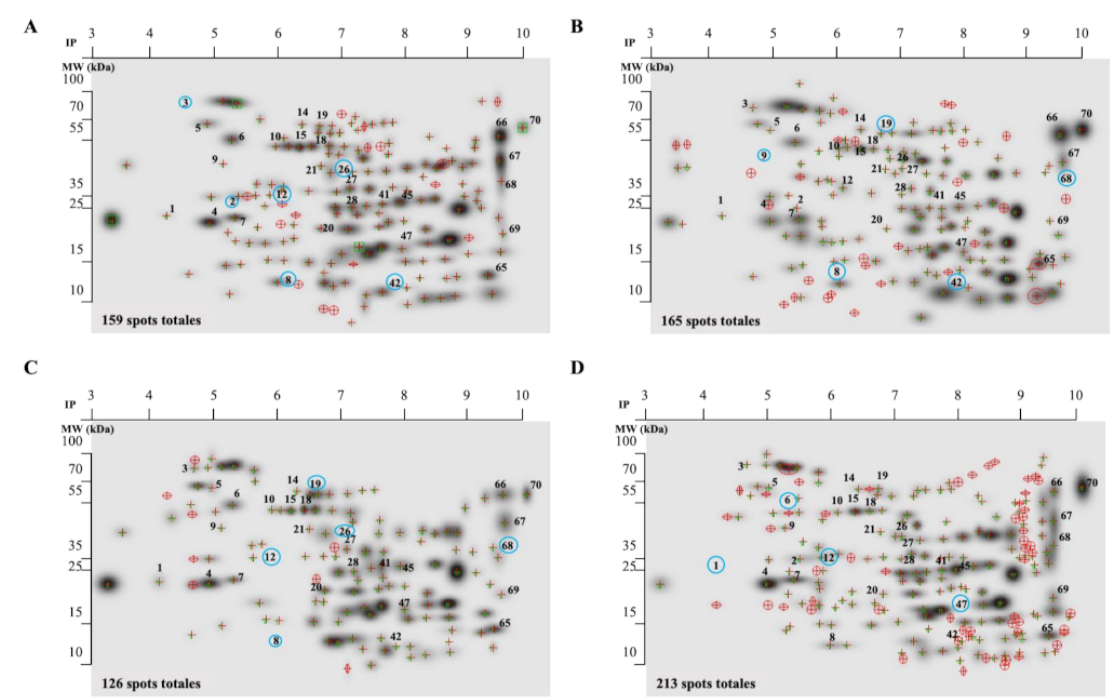
Figure 2. Proteomic profile of the whole extract of extracellular tachyzoites at 30 min of treatment. ( A ) Control without treatment; ( B ) DHEA 10 µ M; ( C ) S-P 800 µ M, and ( D ) DHEA 10 µ M/S-P 800 µ M. The red crosses represent the spots located in each treatment, numbers in the spots represent the proteins analyzed (listed in Table 1), and the blue circles represent the missing proteins in each